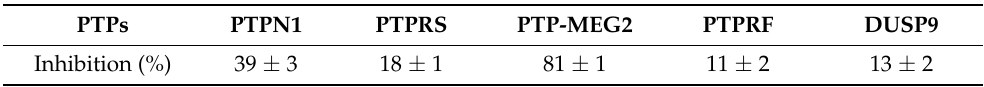
Table 2. Inhibition of PTPs by phloridzin treatment. PTPs were added to solutions containing 200 µ M phloridzin in reaction buffer with DiFMUP (2 × K